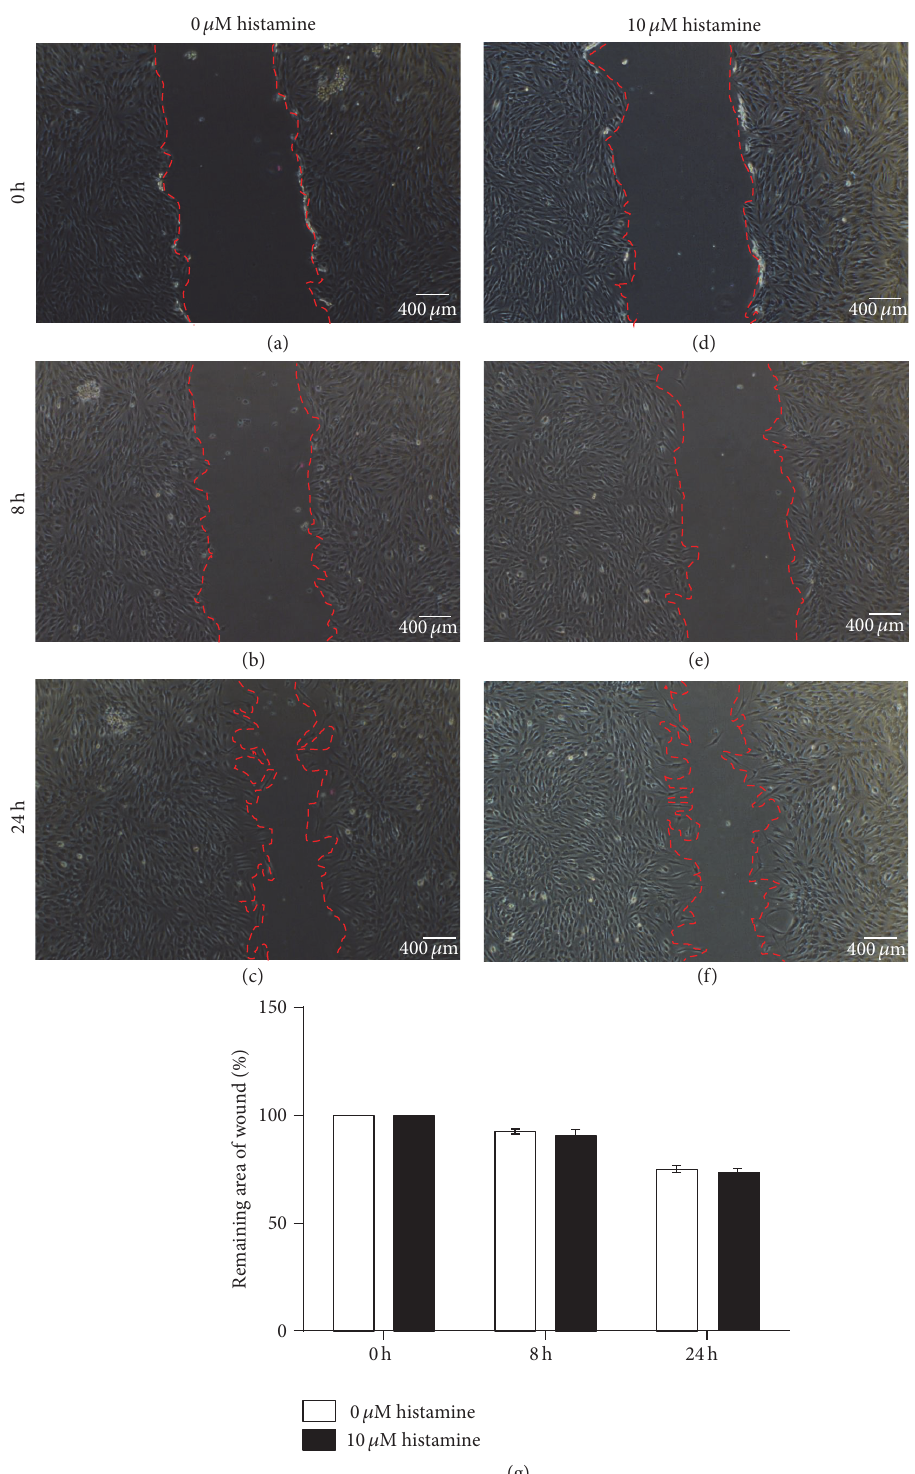
Figure 6: Histamine showed no migratory effect on HPFs. (a, b, c) Photos of wounds in 0 𝜇 mol/L histamine at 0, 8, and 24 h. (d, e, f) Photos of wounds in 10 𝜇 mol/L histamine at 0, 8, and 24 h. (g) The remaining area of wounds in 0 and 10 𝜇 mol/L histamine at 0, 8, and